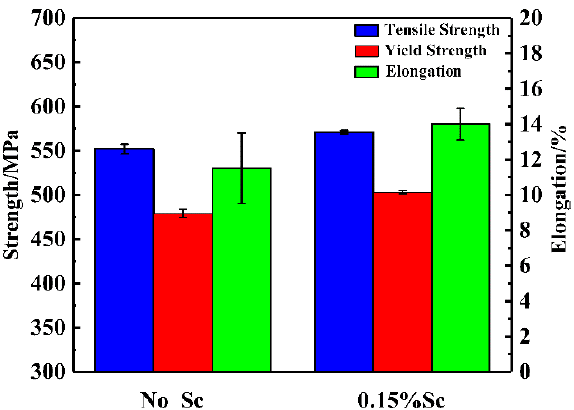
Figure 7. Mechanical properties of alloys under different conditions.